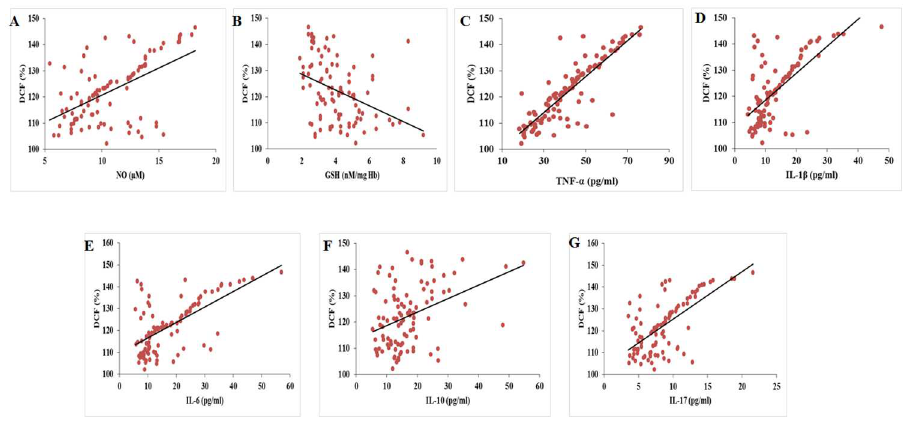
Fig 4. Correlation between ROS and NO (Fig A), GSH (Fig B), TNF- α (Fig C), IL-1 β (Fig D), IL-6 (Fig E), IL-10 (Fig F) and IL-17 (Fig G).